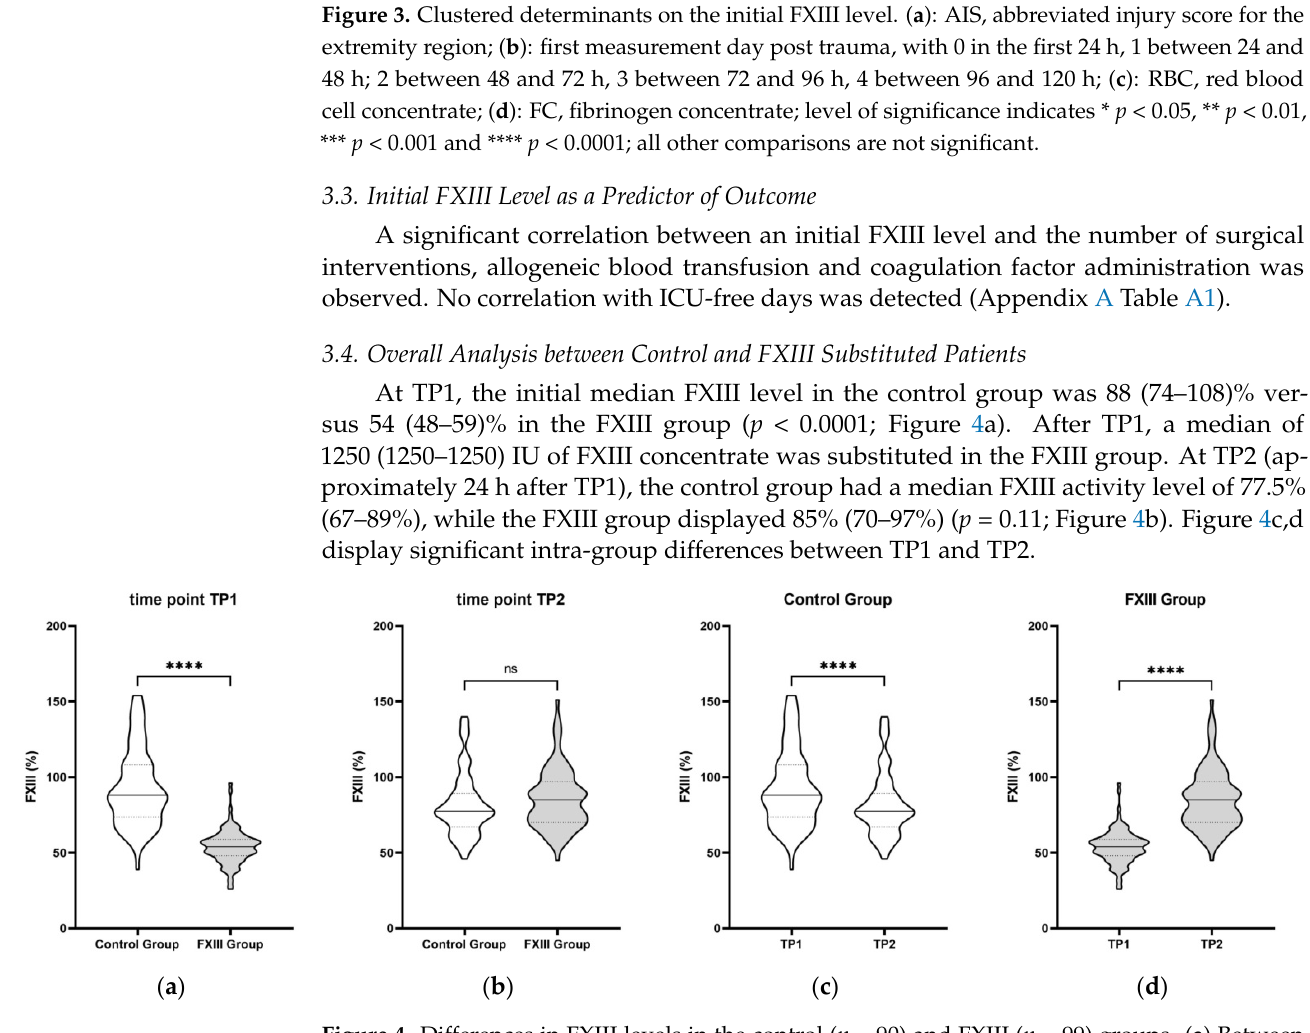
Figure 4. Differences in FXIII levels in the control ( n = 90) and FXIII ( n = 99) groups. ( a ) Between groups at TP1; ( b ) between groups at TP2; ( c ) within control group between TP1 and TP2; ( d ) within FXIII group between TP1 and TP2; TP, time point; level of significance indicates **** p < 0.0001; ns, not significant.